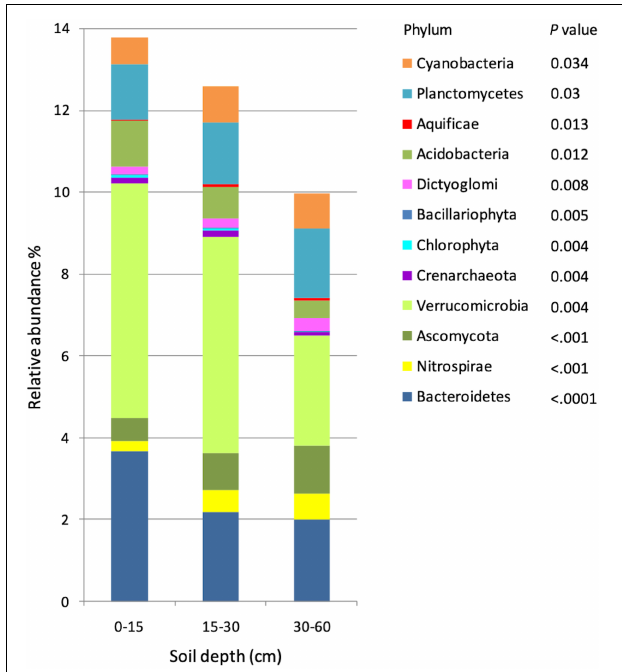
FIGURE 1 | Relative abundance of microbial taxonomic profiles at the phylum level in three soil depths ( n = 15). Phyla were determined using 16s rRNA fragments against the RDP database, and only significantly different phyla among soil depths are showed in the graph. Differences in phyla among depths are indicated by p -values < 0.05.